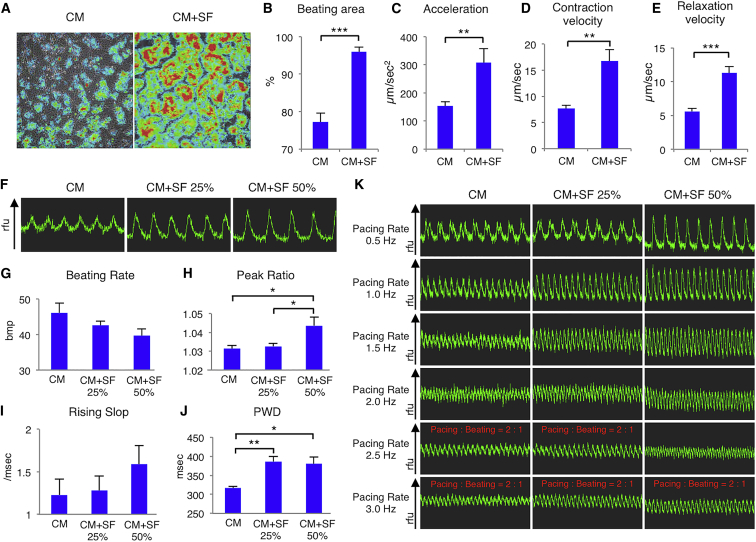
hMSCs Promote Contractile and Electrophysiological Development in hiPSC-CMs(A) Representative velocity data in differentiated cardiomyocytes (CM; left panel) and cardiomyocytes cultured with MSC-derived soluble factors (CM+SF; right panel) by a motion analysis system. Red and blue represent high and low velocity, respectively. (B–E) Percentage of beating area (B), acceleration (C), contraction velocity (D), and relaxation velocity (E) in the CM and CM+SF groups (n = 4 for each group). **p < 0.01; ***p < 0.001, Student t test. (F) Representative wave forms associated with Ca2+ transients in CM, CM with soluble factors secreted from 25% total percentage hMSCs (CM+SF 25%), or CM with soluble factors secreted from 50% total percentage hMSCs (CM+SF 50%), using the FDSS/μCELL system. (G–J) Beating rate (G), peak ratio (H), rising slope (I), or peak width duration (PWD) (J) of cells in the CM, CM+SF 25%, and CM+SF 50% groups as analyzed by FDSS software U8524-12 (n = 6 for each group). *p < 0.05; **p < 0.01, one-way ANOVA with post hoc Tukey’s HSD test. (K) Representative wave forms associated with Ca2+ transients in CM, CM+SF 25%, and CM+SF 50% cells with a pacing rate of 0.5, 1, 1.5, 2, 2.5, or 3 Hz. For all experiments, results are shown as mean + SEM.